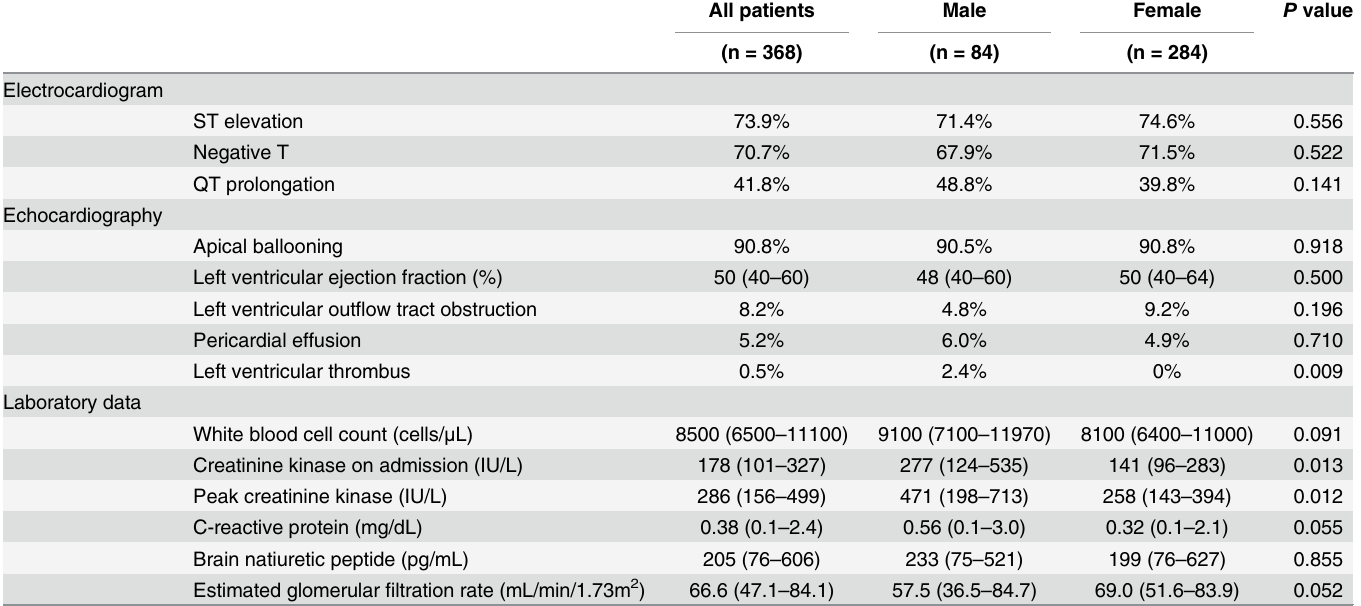
Table 2. Electrocardiographic findings, echocardiographic findings, and laboratory